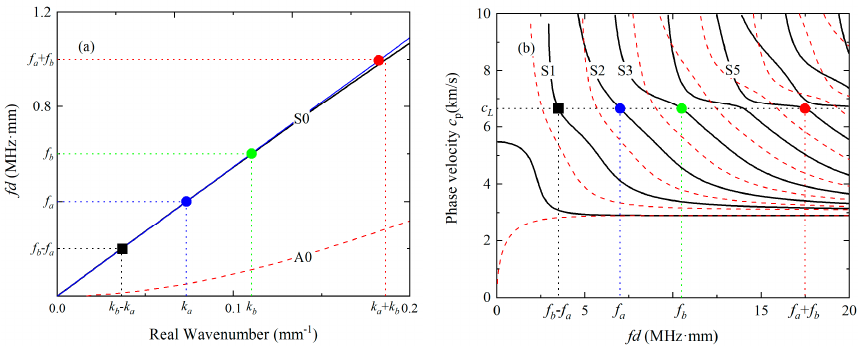
Figure 1. Dispersion curves for the 6061-T6 aluminum alloy plate. The first ( a ) and second ( b ) mode triplet that approximately and exactly satisfies the phase matching criterion are marked.